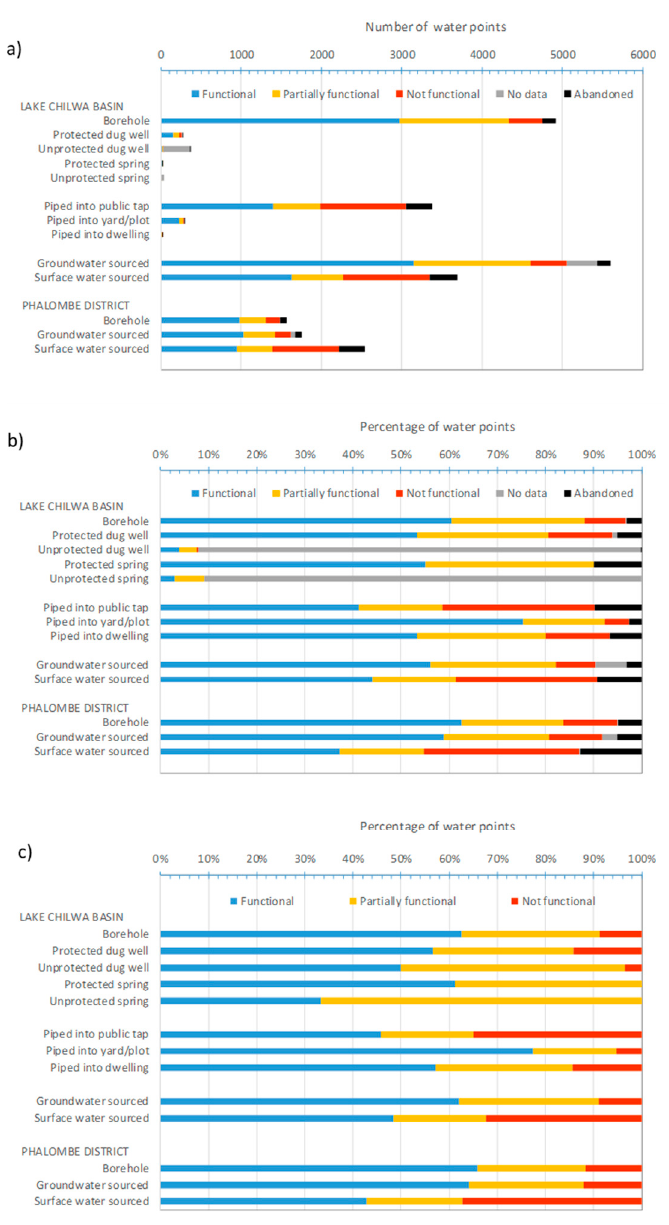
Figure 13. Water point functionality breakdown of Lake Chilwa Basin and Phalombe District subset surveyed in 2019 (based on mWater data retrieval May, 2020) showing: ( a ) numbers of water points; ( b ) percentage functionality across all five functionality categories; ( c ) percentage functionality across functional partially functional and not functional categories (three categories).